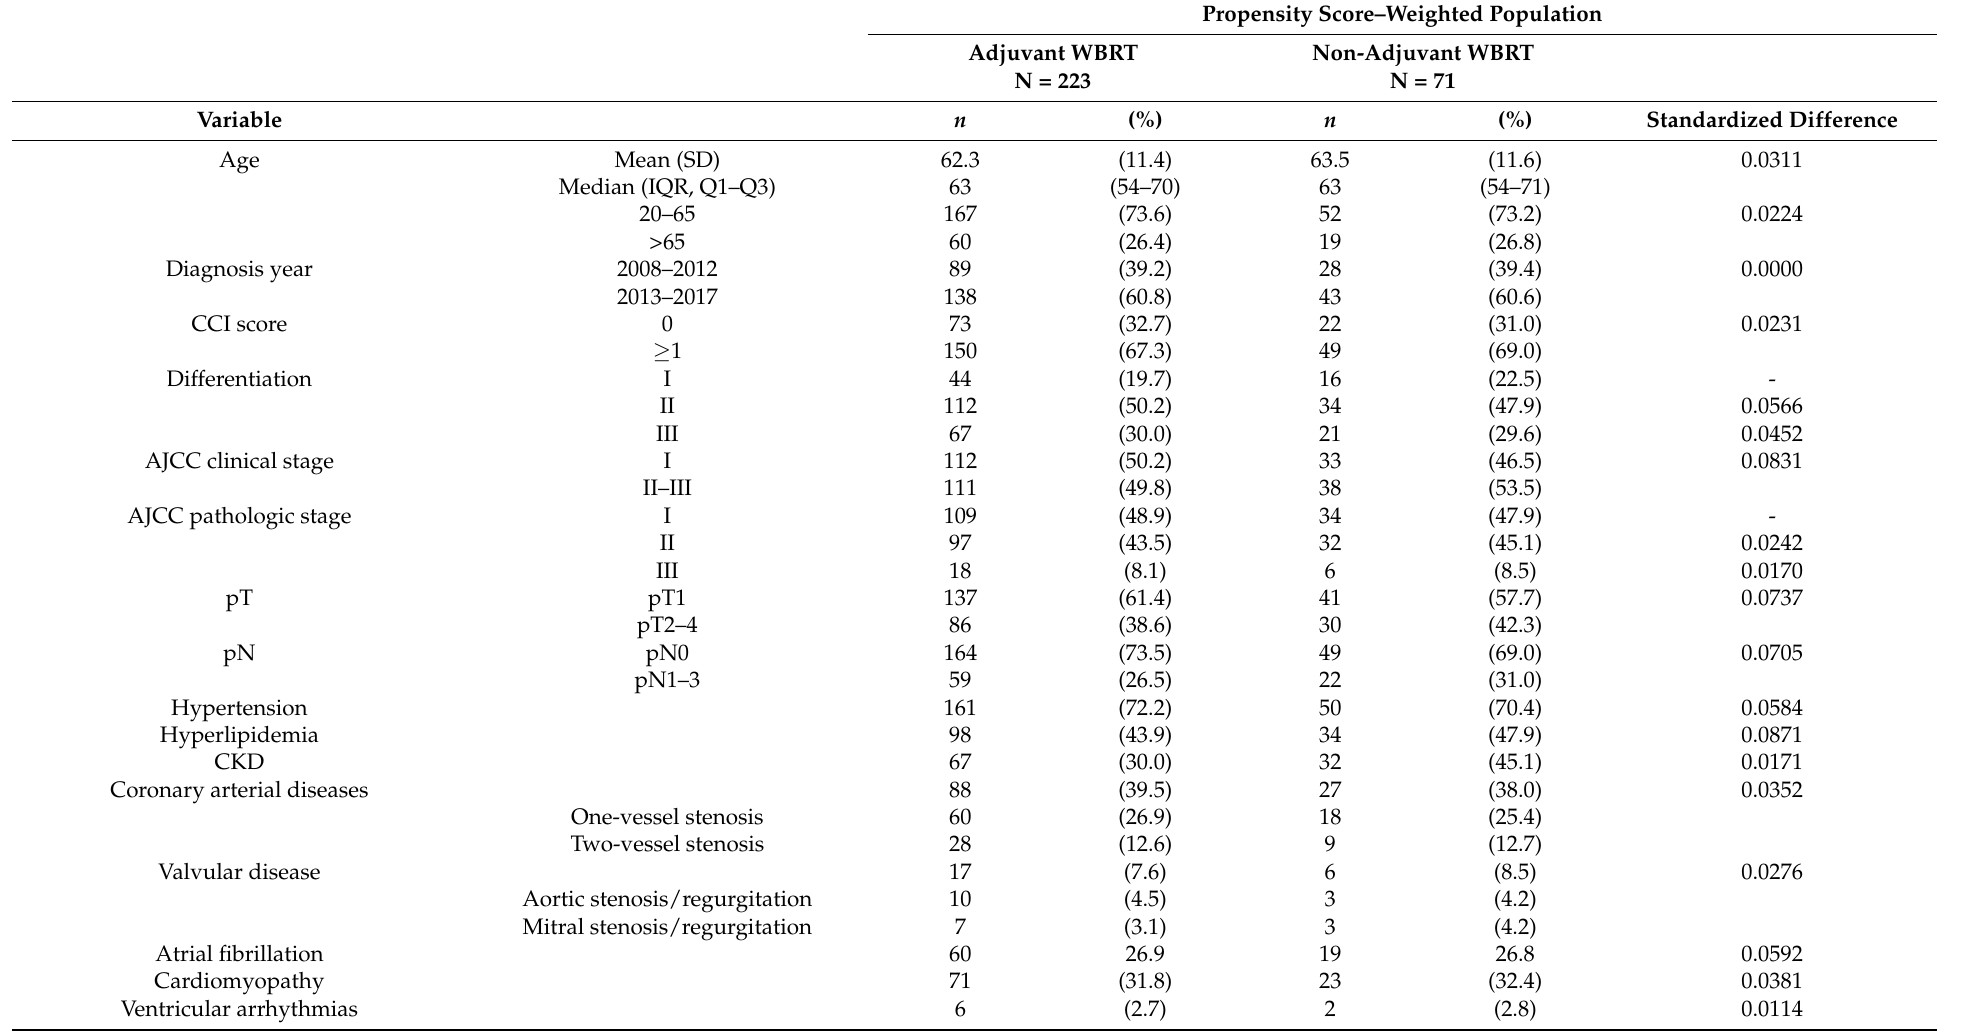
Table 1. Demographics of patients with breast cancer and heart failure with reduced ejection fraction who received breast conservative surgery in the propensity score–weighted population through inverse probability of treatment weighting